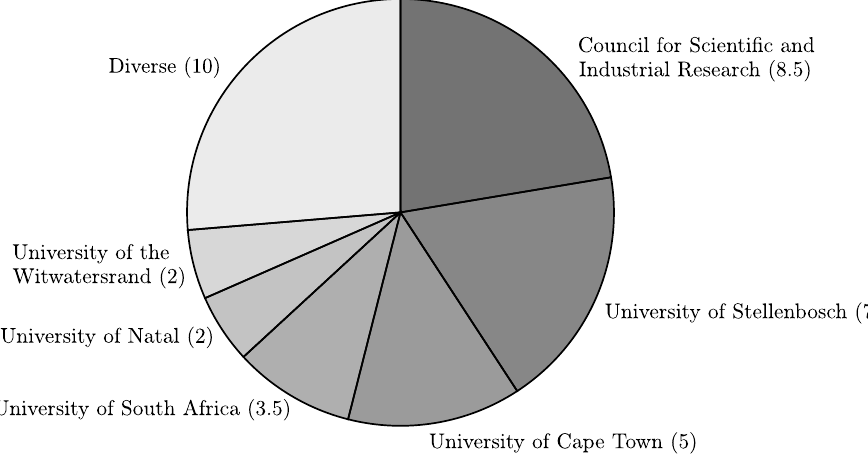
Figure 1: The TR medal winners categorized by